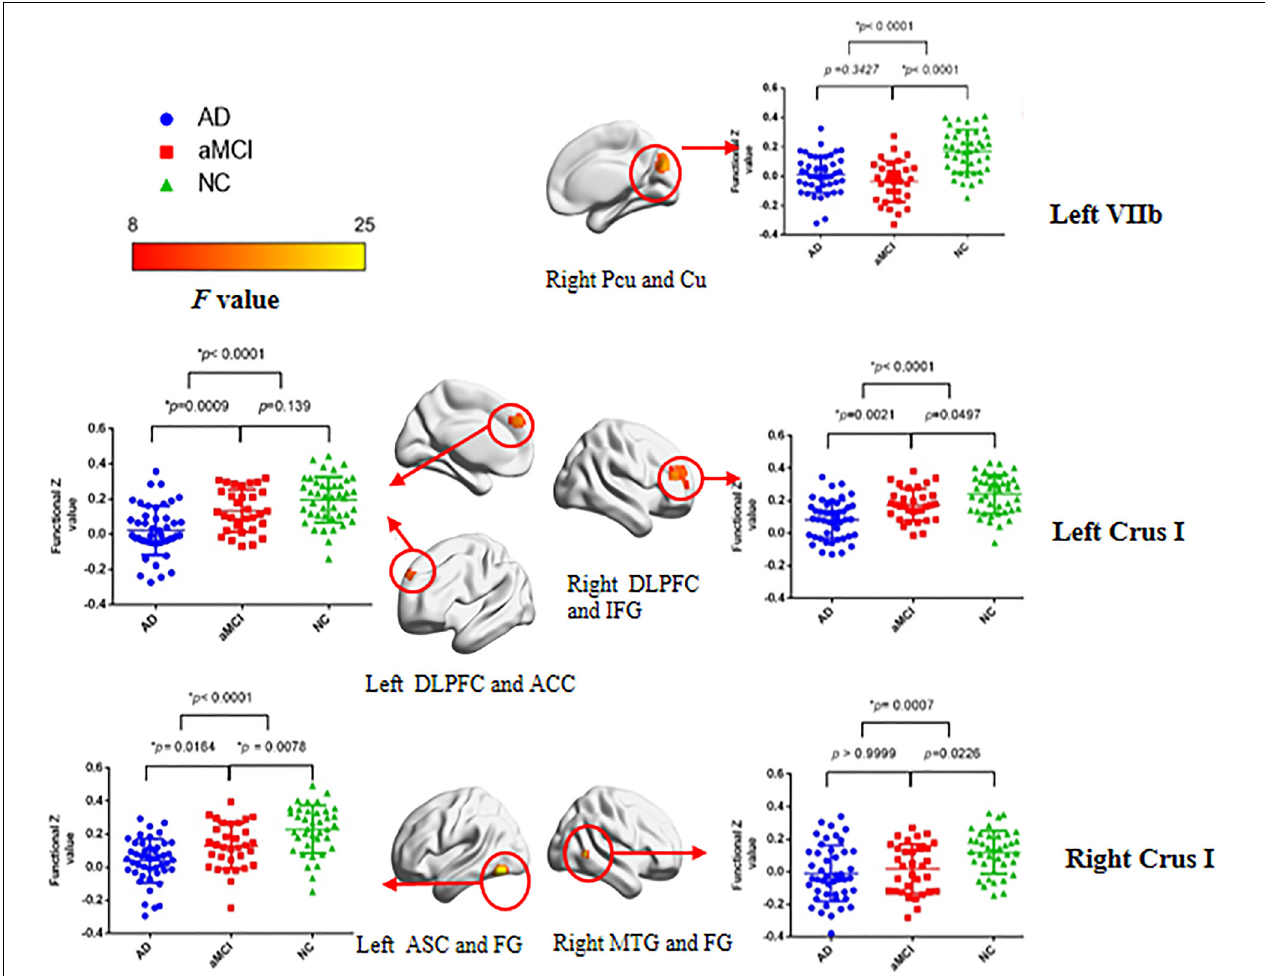
FIGURE 3 | Statistical parametric map and the scatterplot of the significant cerebral cortical clusters among three groups and the post hoc analysis between groups. Each row corresponds to a distinct cerebellar lobular seed region of interest. The difference remained significant after Bonferroni correction at post hoc analysis. Color bar represents F values. BrainNet Viewer (Beijing Normal University, http://www.nitrc.org/projects/bnv/) was used for the visualization of the results. L, left; R, right; Bi, bilateral; PCu, precuneus; Cu, cuneus; DLPFC, dorsolateral prefrontal cortex; IFG, inferior frontal gyrus; ACC, anterior cingulate cortex; ASC, associative visual cortex; MTG, middle temporal gyrus; FG, fusiform gyrus.